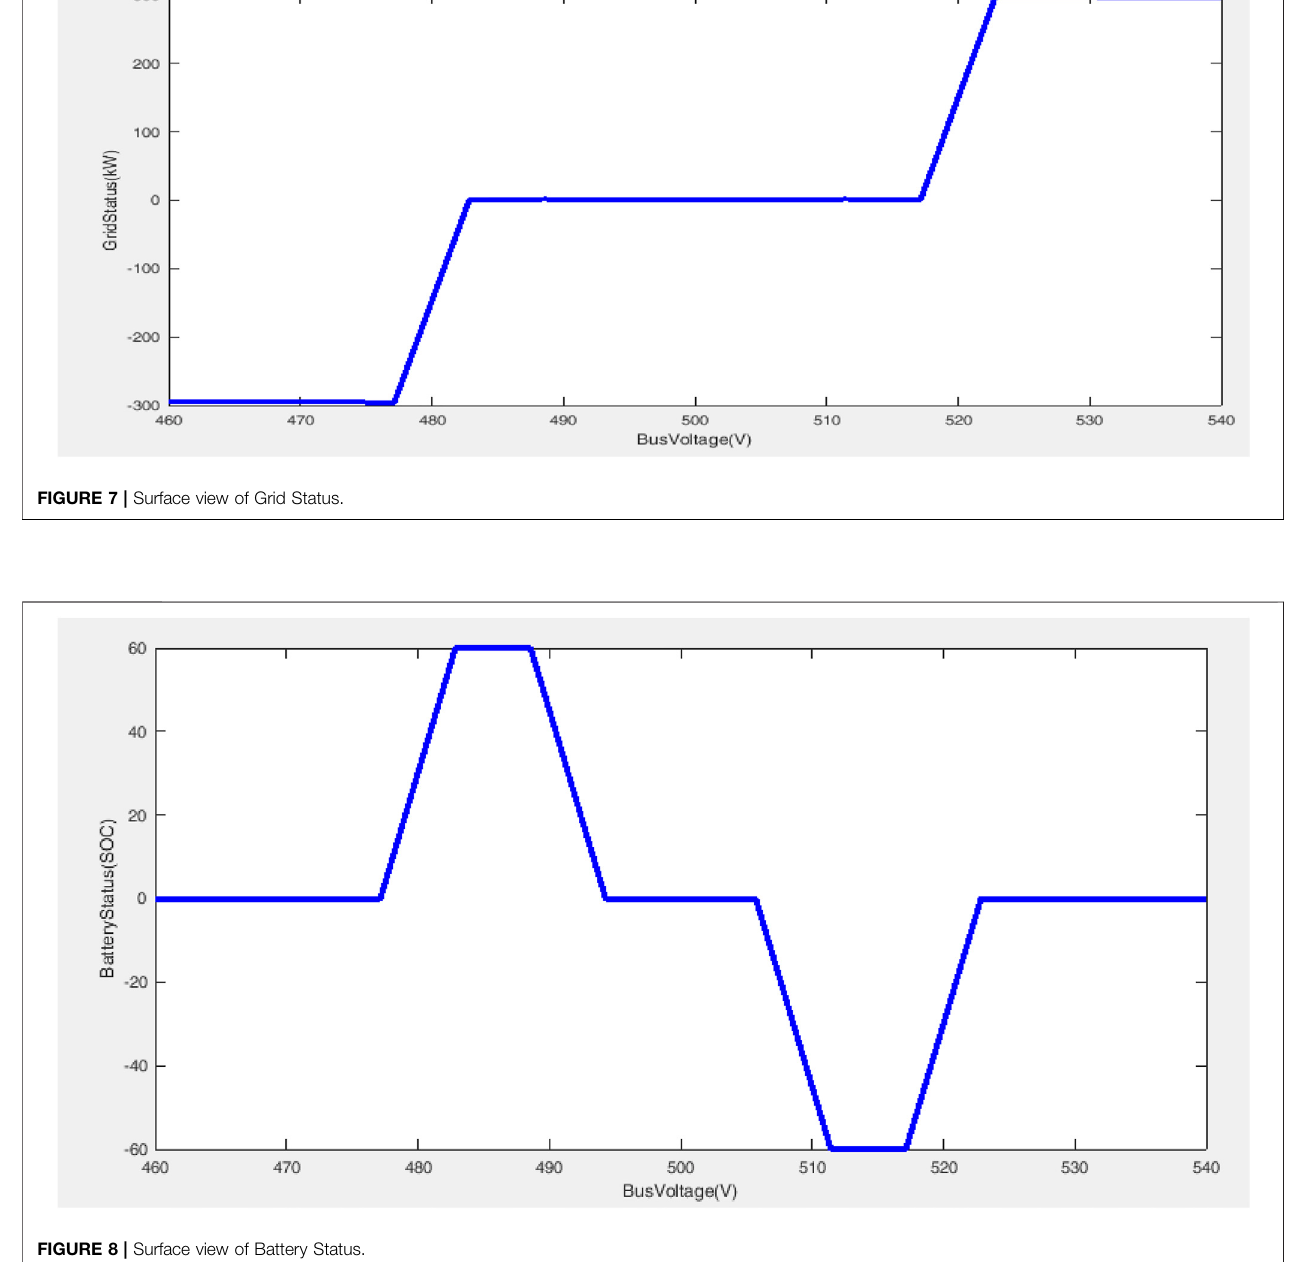
FIGURE 8 | Surface view of Battery